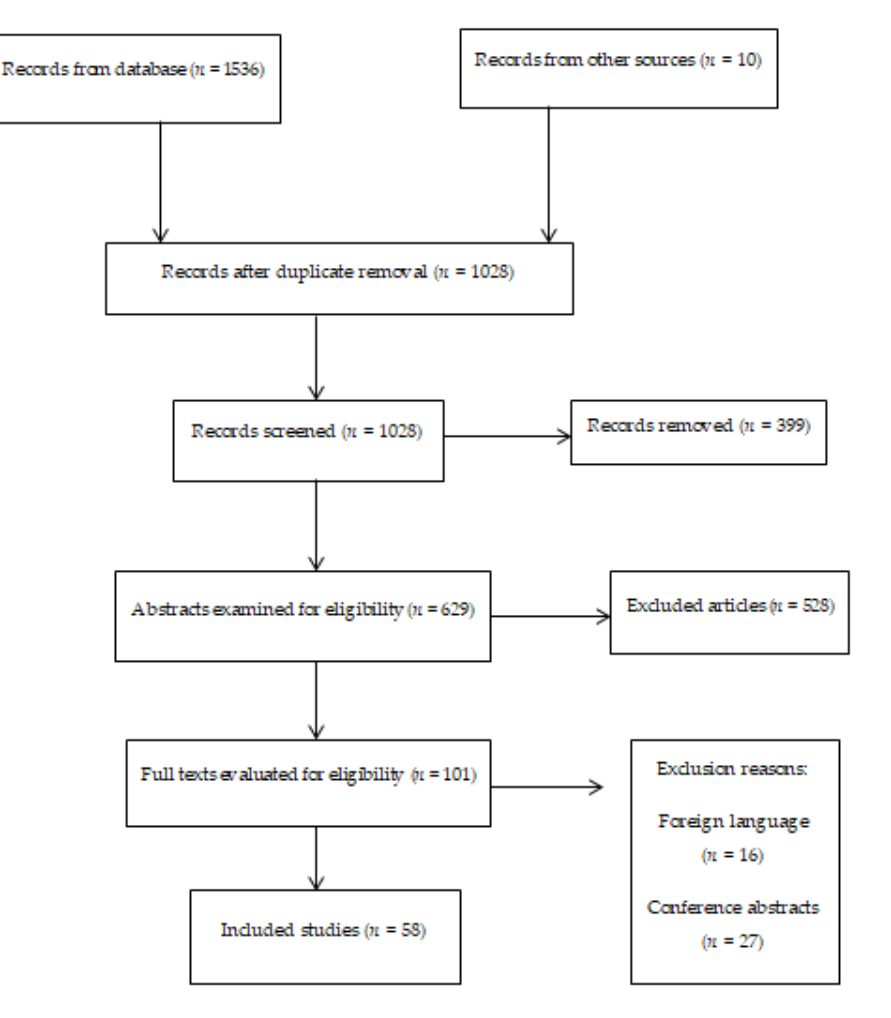
Figure 1. PRISMA flowchart .